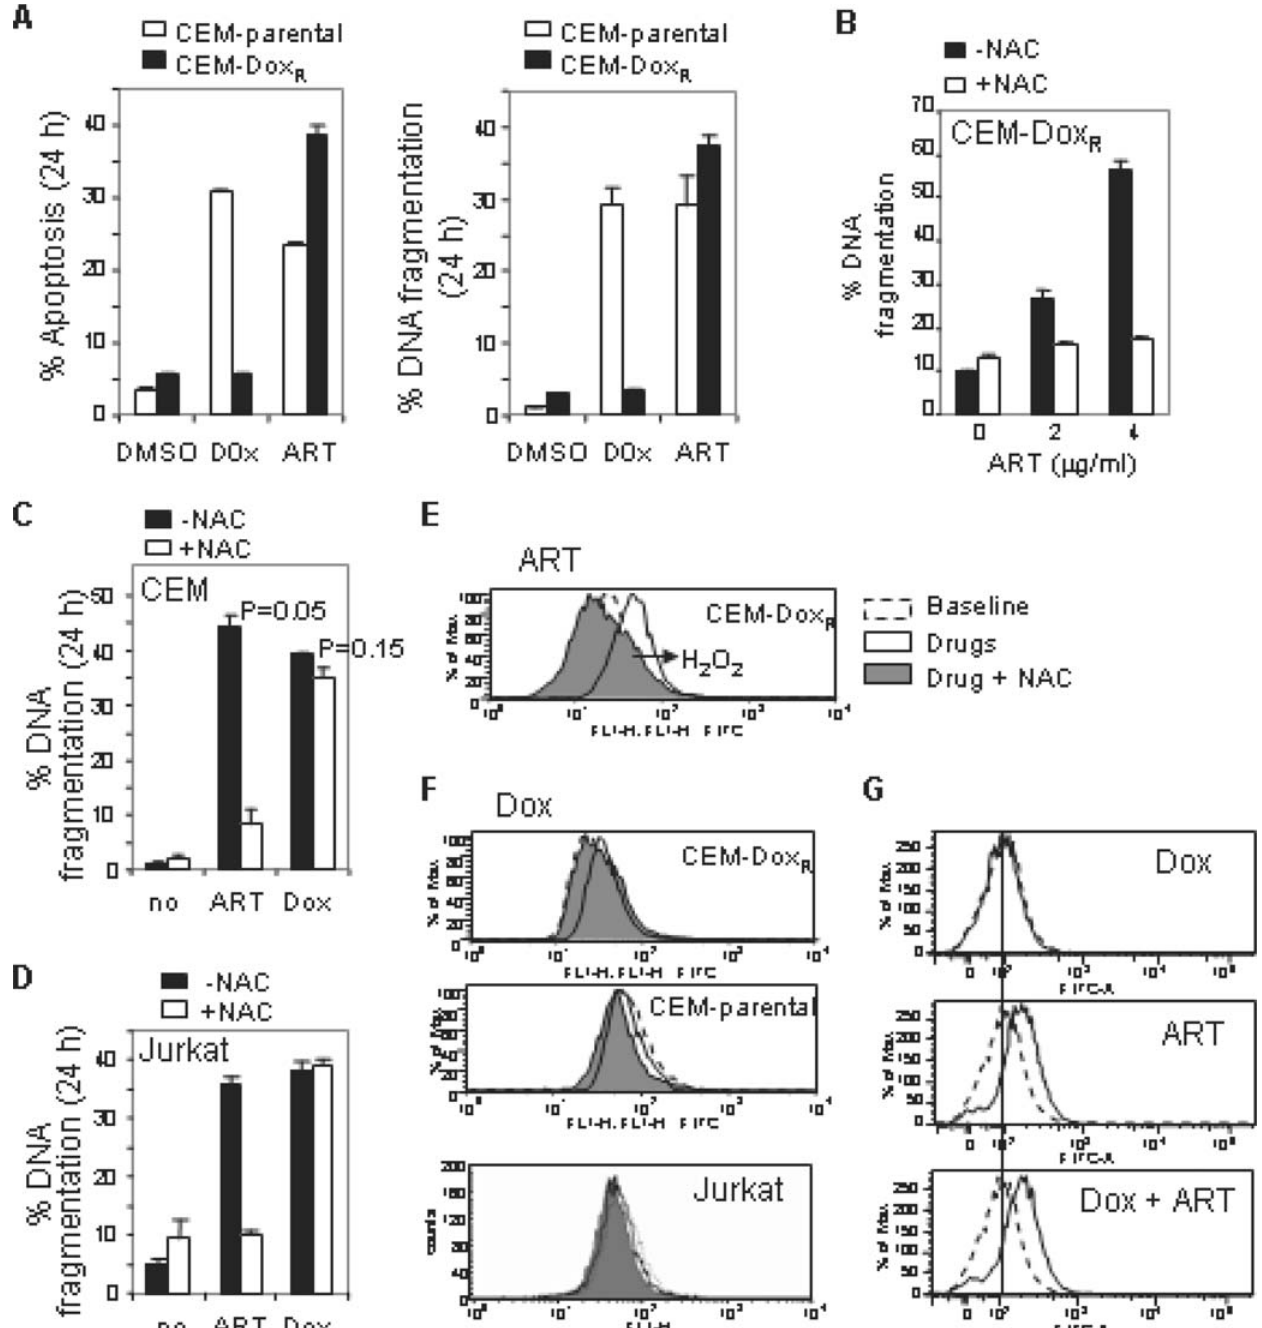
Figure 4. ART induces Doxorubicin-resistant leukemic cells to undergo apoptosis by a mechanism different from the one induced by Doxorubicin. (A) ART induces apoptosis in Doxorubicin-resistant leukemic cells. Doxorubicin-resistant (CEM-Dox R ) and parental (CEM-parental) CEM cells were treated with either 1 m g/ml of ART or 0.5 m g/ml of Doxorubicin for 24 h. Apoptosis was determined by FSC/SSC (left panel) and DNA fragmentation (right panel). Results are representative of two independent experiments. (B) NAC inhibits ART-induced apoptosis in Doxorubicin- resistant leukemic cells. CEM-Dox R cells were treated with different doses of ART in the presence or absence of NAC (15 mM). Apoptotic cell death was determined by DNA fragmentation in triplicates. (C) and (D) NAC does not inhibit Doxorubicin-induced apoptosis. CEM-parental (C) and Jurkat (D) cells were treated either with ART or Doxorubicin in the presence or absence of NAC. Apoptotic cell death was determined by DNA fragmentation. Results are representative of four independent experiments. The p value was determined by the statistic program of Microsoft Excel. (E) ART induces ROS generation in CEM-Dox R cells. CEM-Dox R cells were treated with 4 m g/ml of ART in the presence or absence of NAC (15 mM) for 30 min. The redox status was measured as in figure 3. (F) Doxorubicin does not induce ROS in leukemic T cells. CEM-Dox R , CEM-parental and Jurkat cells were treated with 0.5 m g/ml of Doxorubicin in the presence or absence of NAC for 30 min. The redox status was measured as in (E). Results are representative of three independent experiments. (G) Doxorubicin does not interfere with the redox assay. CEM cells were treated with Doxorubicin (2 m g/ml) or ART (4 m g/ml) alone or in combination for 30 min. The redox status was measured as in F.